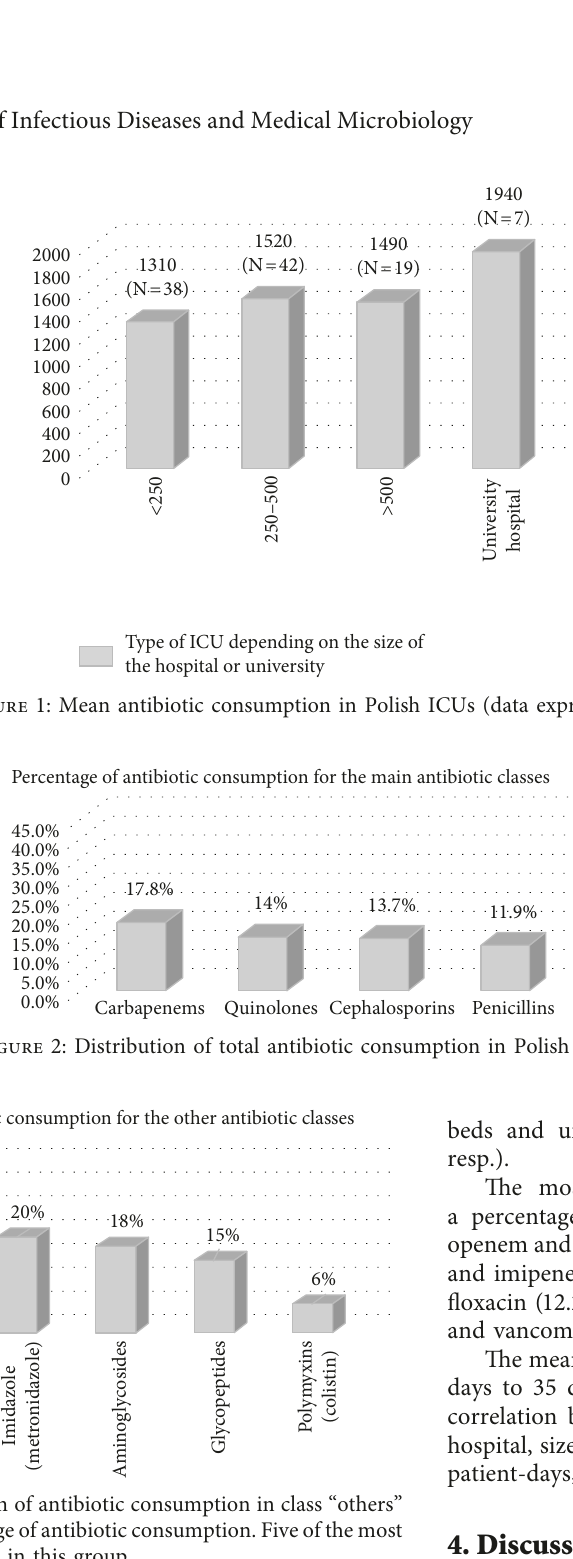
individual number. The main antibiotic classes are shown in different colours. The size and colour of each column cor- respond to the amount and type of antibiotic class used. The ICUs are presented in order of decreasing antibiotic use.